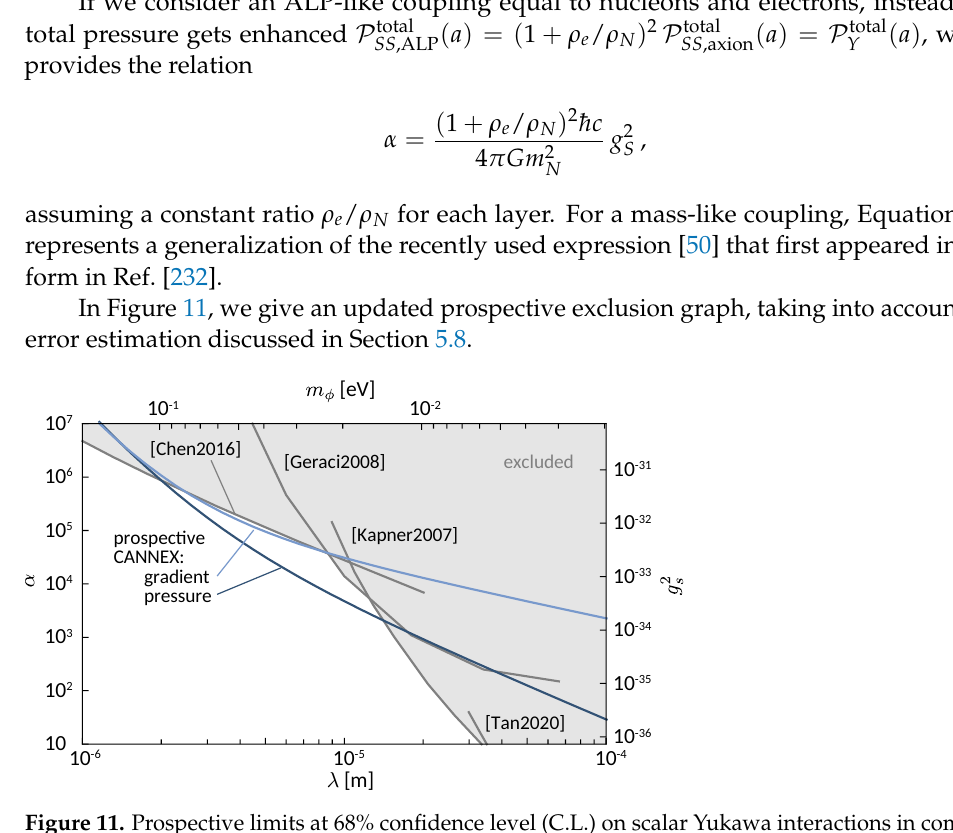
Figure 11. Prospective limits at 68% confidence level (C.L.) on scalar Yukawa interactions in compari- son with existing limits at 95% C.L. from a recent Casimir experiment [42] [Chen2016], Cavendish- type micro-oscillator [27] [Geraci2008], and torsion balances [26,33] [Kapner2007] and [Tan2020], respectively. Scales for the generic coupling constant g 2 and the traditional mass-coupling constant α S are related according to Equation (41) and indicated on the right and left axes,